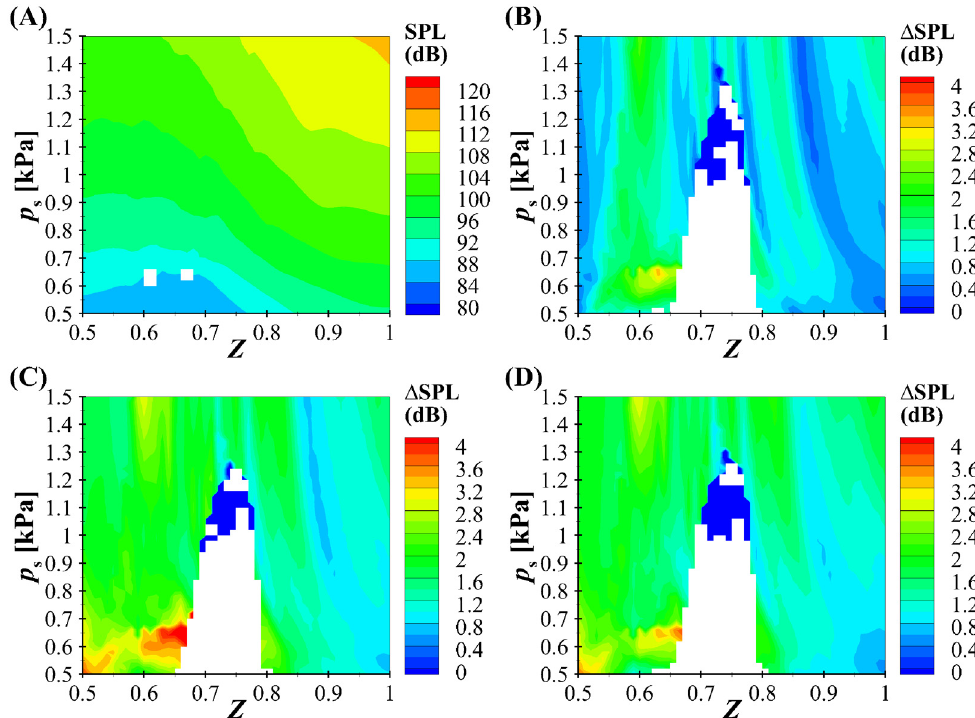
Fig 9. Regime map of the radiated sound pressure level (SPL). A: Bernoulli-WRA (Case 1), B: the difference between BLEAP-WRA (Case 2) and Bernoulli-WRA (Case 1), C: the difference between BLAST (Case 3) and Bernoulli-WRA (Case 1), and D: the difference between BLAST- n ( t ) (Case 4) and Bernoulli-WRA (Case 1). The white color corresponds to the regions where no repeating pattern of oscillation was found in Fig 7.